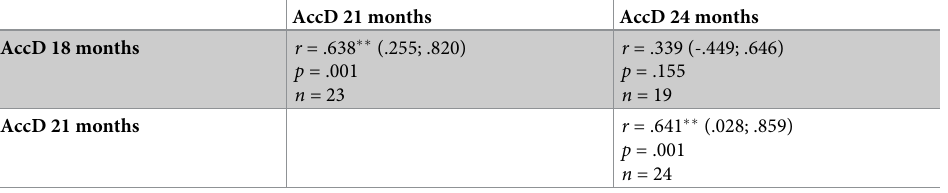
Table 2. Correlations between accuracy difference (AccD) scores at 18, 21 and 24 months of age in the longitudi- nal sample in Study 2 (95% confidence intervals in brackets, using bootstrapping with 1000 samples).